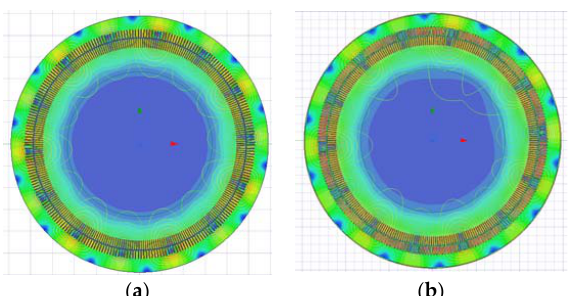
Figure 6. The finite element analysis model; ( a ) the distribution of magnetic density and magnetic force line during normal operation; ( b ) the distribution of magnetic density and magnetic force line after the rotor winding has a short ‐ circuit fault.